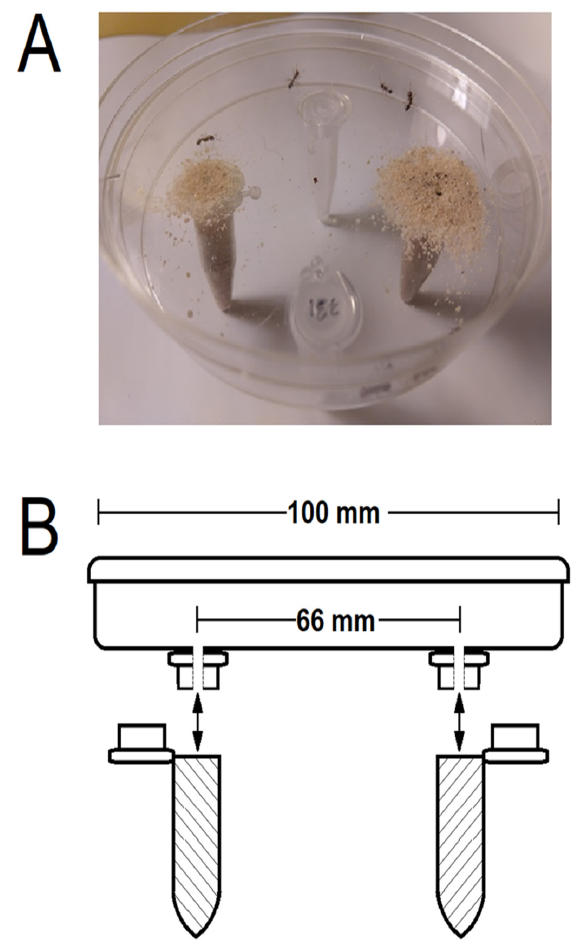
Figure 1. ( A ) A photograph of the bioassay apparatus with active RIFA workers present. The treatment (left) and control (right) sand vials are positioned on opposite sides of an arena. RIFA ( n = 20 or 6 per assay, dependent on assay) excavate sand from available vials; excavated sand is quantified, and ant positions are determined to infer repellency/attraction of bacterial treatments. Two additional empty support vials are fixed to the Petri dish to provide stability to the apparatus. ( B ) A diagram of the bioassay apparatus. The caps of two 1.5 mL microcentrifuge tube caps are fixed to the bottom of a 100 mm petri dish; holes (3 mm) are spaced 66 mm apart through the caps and